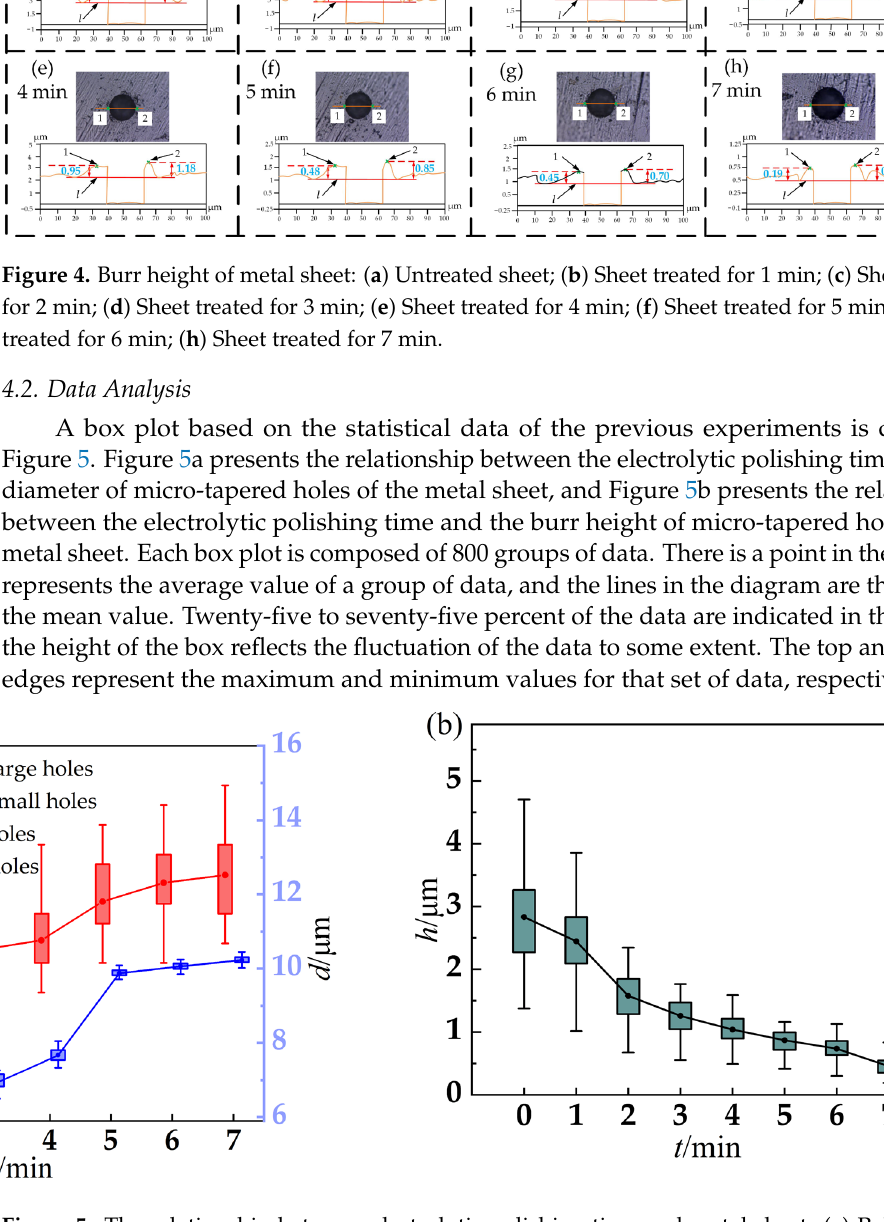
Figure 3. Picture of ultra-depth-of- field 3D microscopic measurement : ( a ) Microscope measurement object diagram; ( b ) Schematic of enlarging the burr height of the metal sheet.